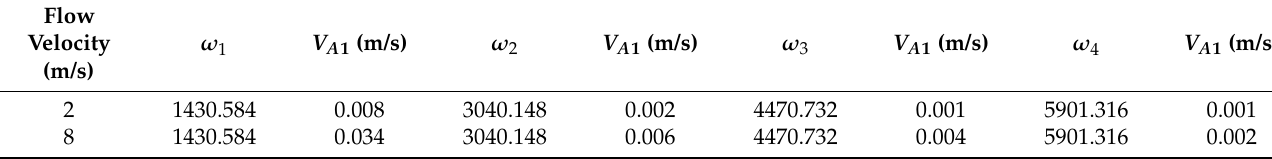
Table 4. Spectrum characteristics of flow